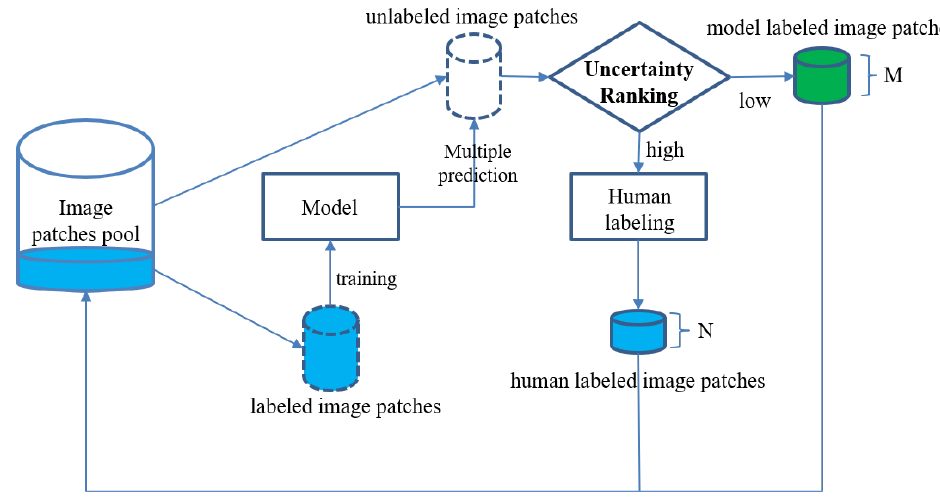
Figure 4. The overall flowchart of our semisupervised active learning